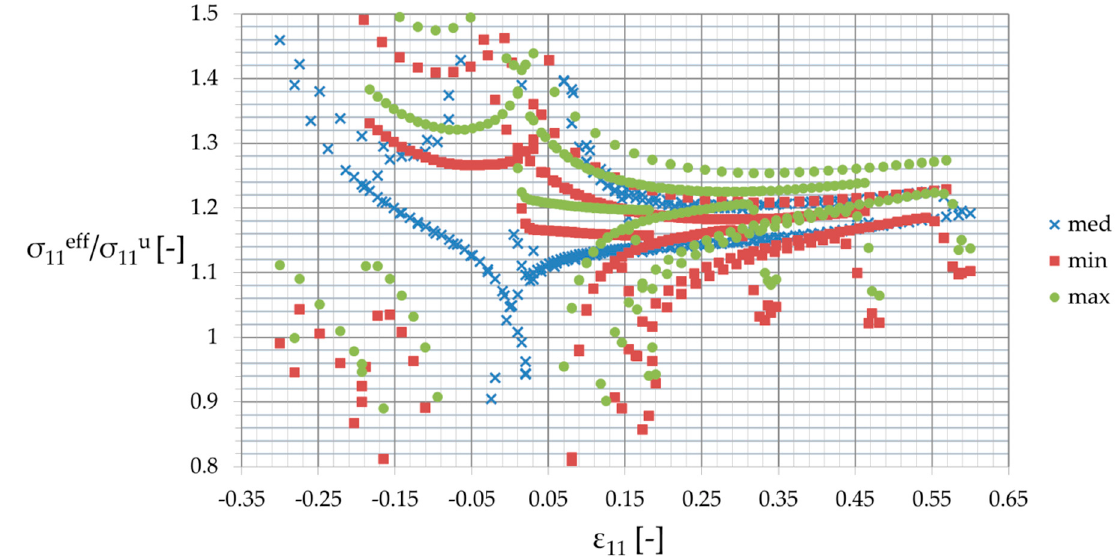
Figure 7. Strengthening ratios for the polymer after reinforcing.